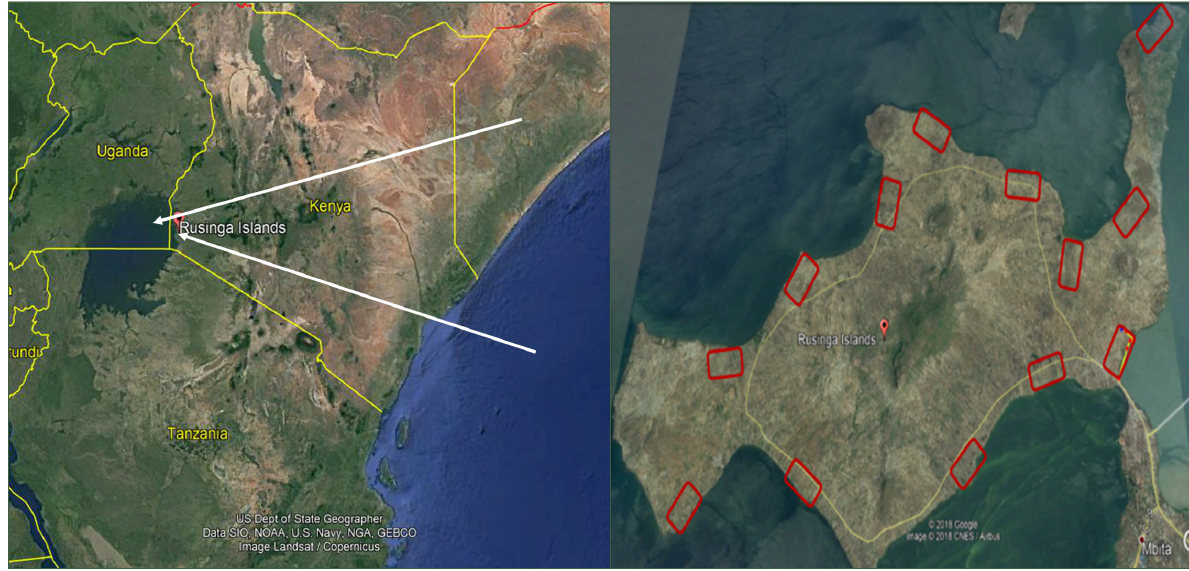
Figure 1. Map showing ( A ) Lake Victoria region, East Africa ( B ) the study clusters (rectangles in red) along the shores of Lake Victoria on Rusinga Island (Source: Google